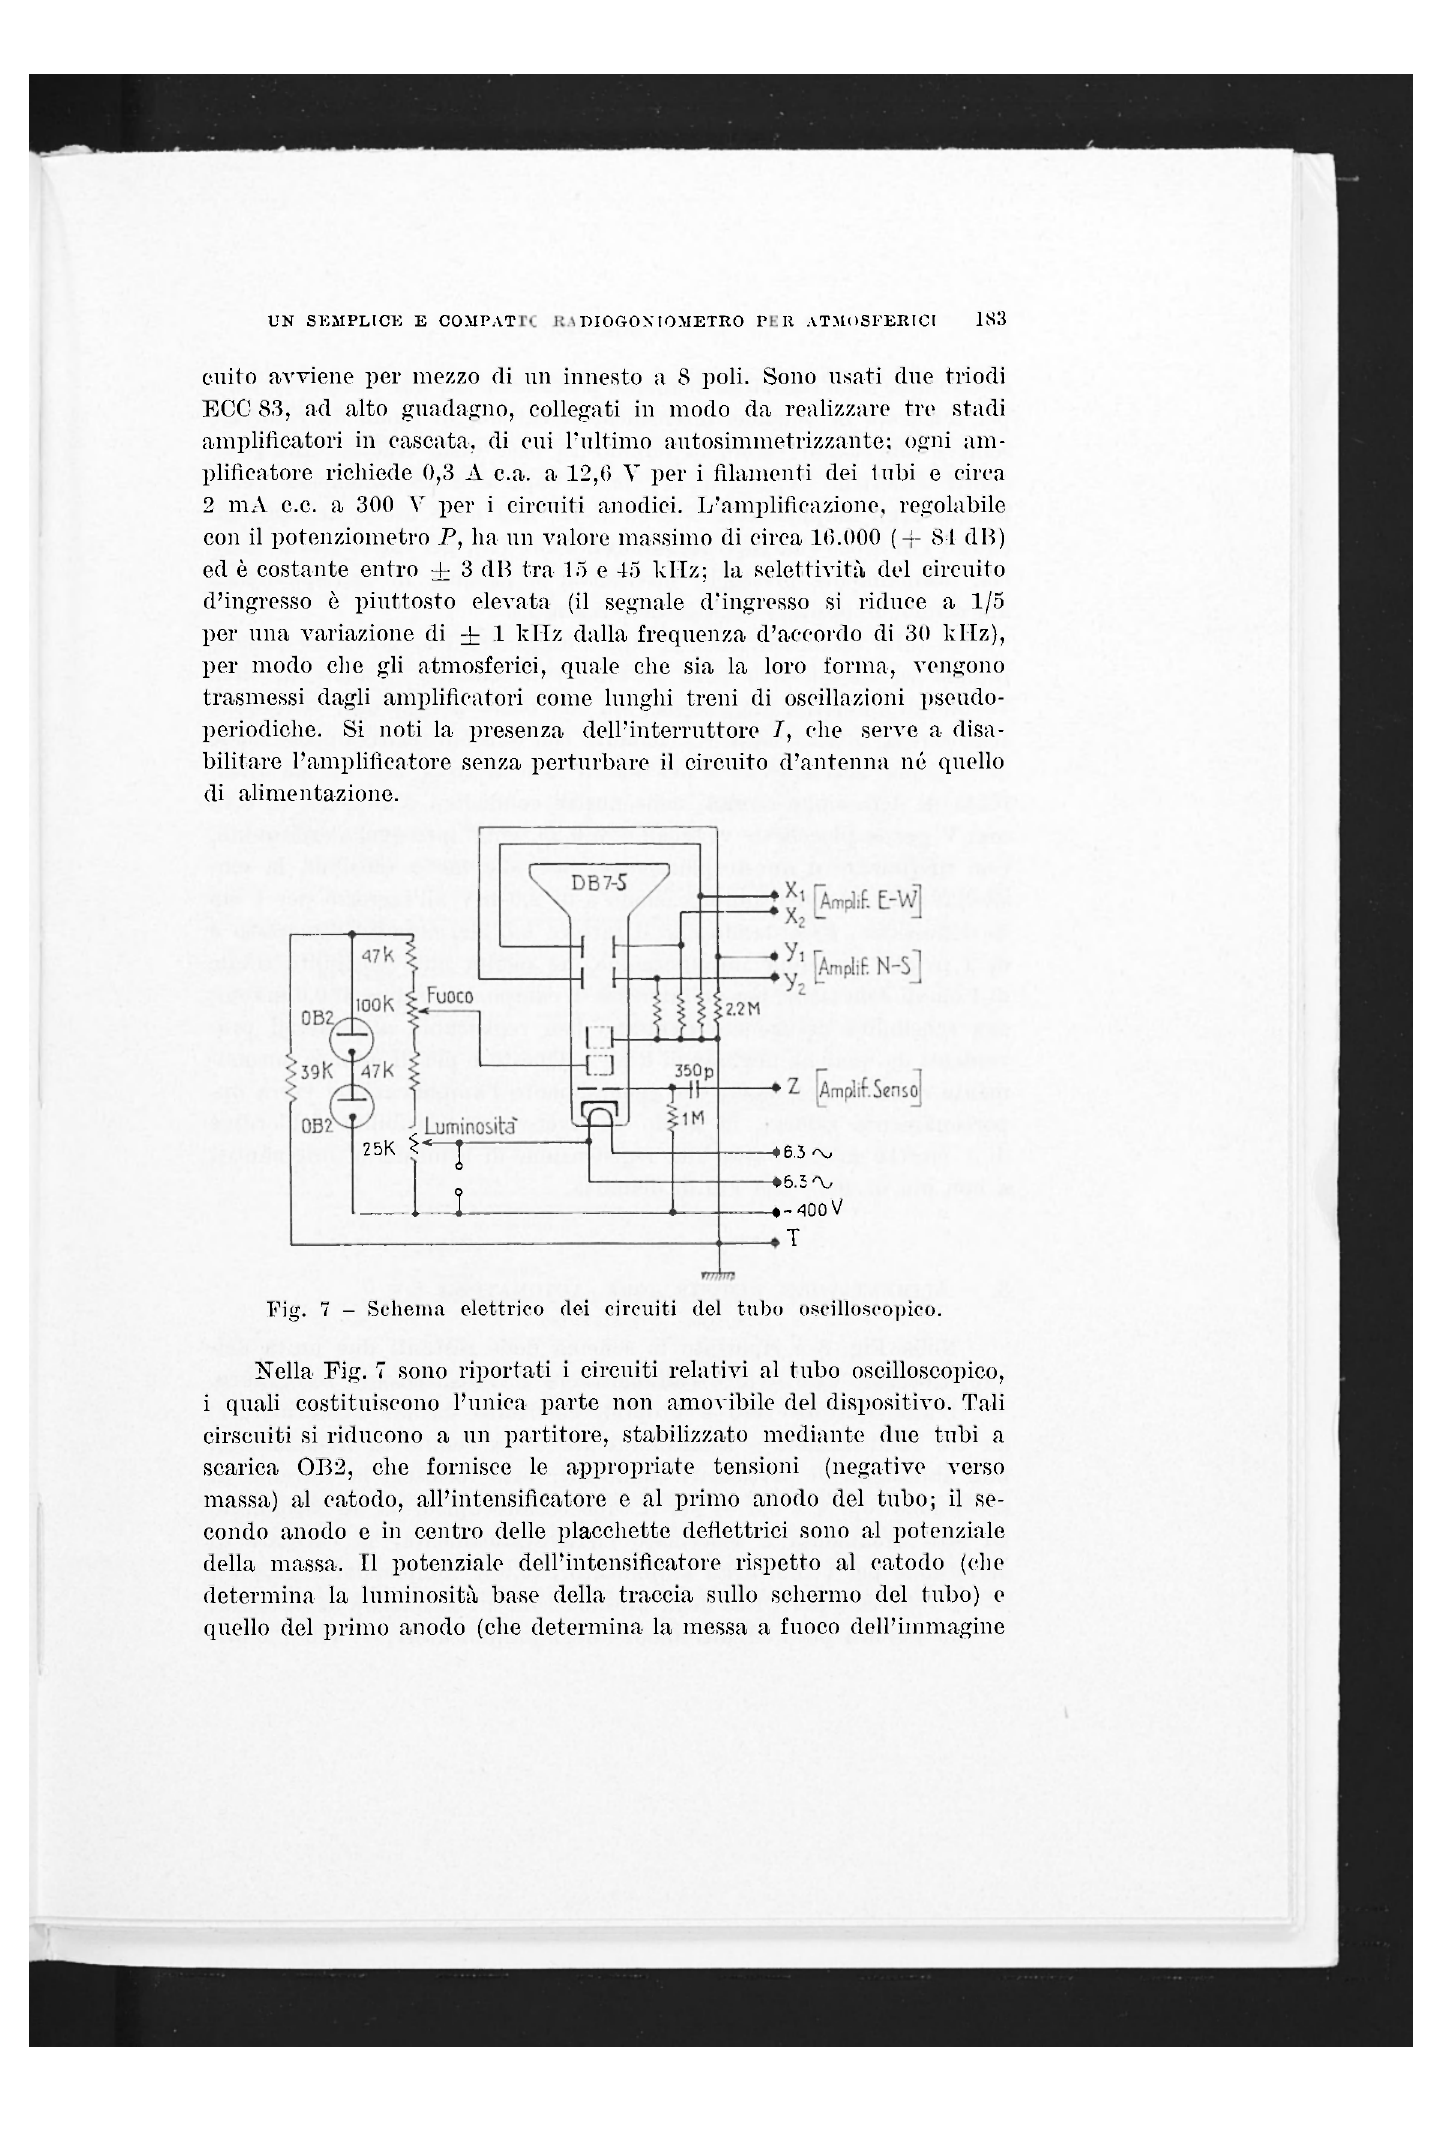
Fig. 7 - Schema elettrico dei circuiti del tubo